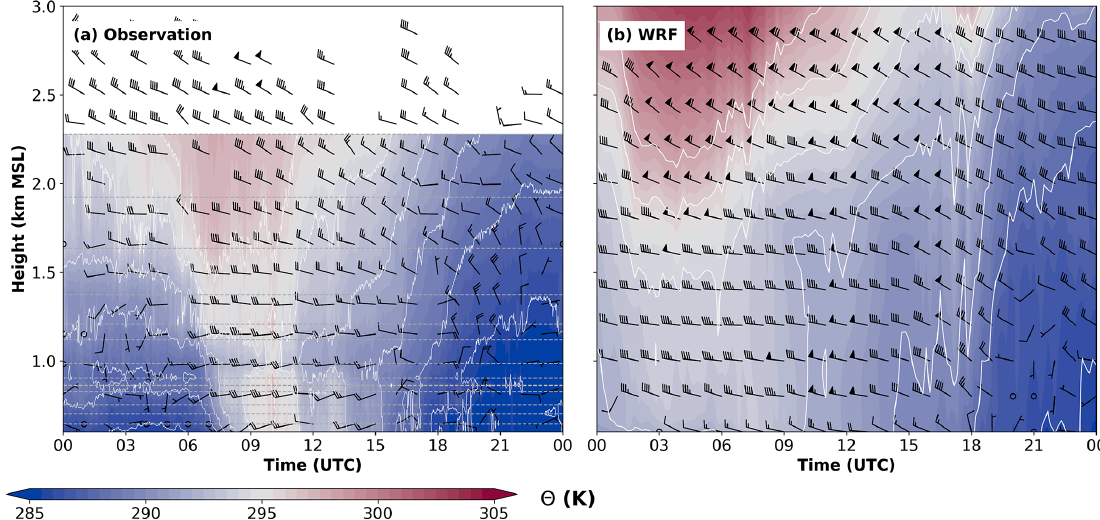
Figure 5. Time–height diagram of (a) observed and (b) simulated potential temperature and mean horizontal wind in Innsbruck on 29 October 2017. Potential temperature is shown by color contours and white contour lines with a spacing of 2K, wind barbs indicate wind speed and direction as in Fig. 2. Temperature measurements were conduced along the slope profile SP_NK, and gray horizontal lines indicate the measurement heights. Wind barbs are shown at an hourly interval and represent 10min averages of the horizontal wind measured with the Doppler wind lidar SL88. Potential temperature and wind in (b) are 10min averages of the time series of every integration time step at the WRF grid point closest to UNI.